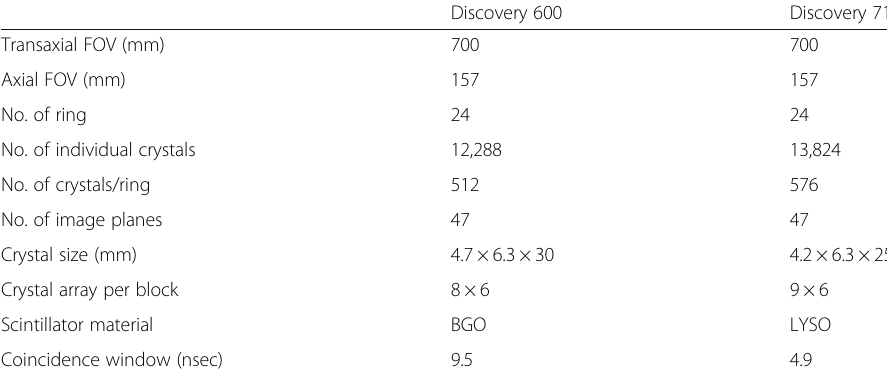
Table 1 Comparison of device features